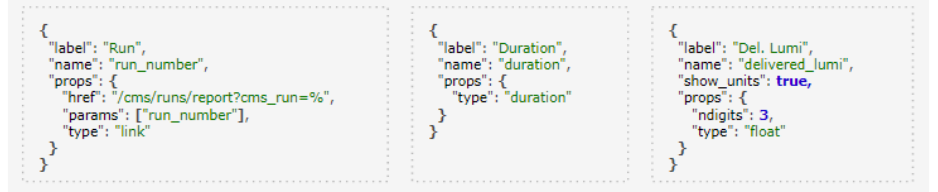
Figure 5. Master-details. Portlet on the right side displays selected series from the left portlet